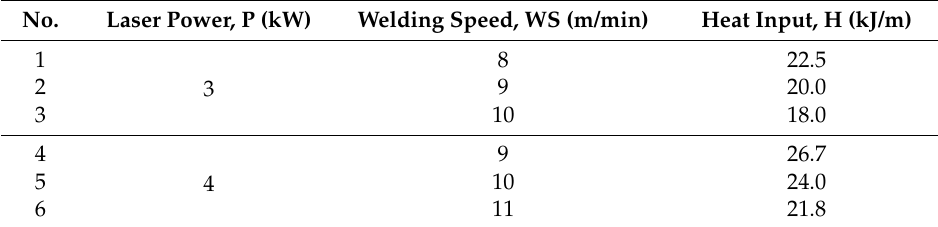
Table 2. Laser welding